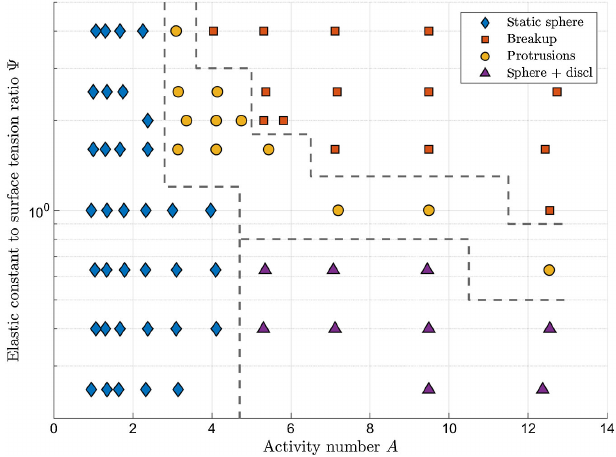
FIG. 11. Morphology diagram of extensile droplets ( ζ > 0 ) as a function of the activity number A ¼ R constant to surface tension ratio K are varied, while the surface tension and droplet size are fixed to one of the following values: K φ ∈ f 0 . 1 ; 0 . 2 g and R ∈ f 15 ; 30 g .